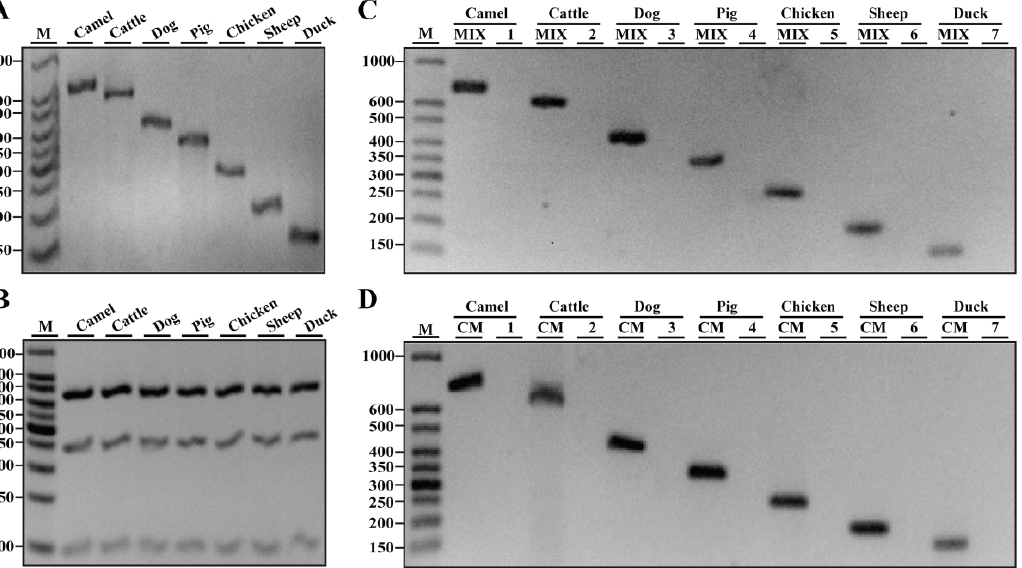
Figure 1. Verification of primer specificity with conventional simplex PCR. ( A ) Simplex PCR detec- tion using species-specific primers for camel, cattle, dog, pig, chicken, sheep and duck origin and respective genomic DNA as the template. ( B ) PCR amplification with premixed universal primers of eukaryotic 12S rRNA, 16S rRNA and 18S rRNA genes for each meat species, respectively. ( C ) PCR amplification using individual template DNA from camel, cattle, dog, pig, chicken, sheep and duck species. MIX, a mixture of seven primer pairs of camel, cattle, dog, pig, chicken and sheep species; 1–7, a mixture of six primer pairs of six nontarget species. ( D ) PCR amplification with a pair of target primers. CM, a complete DNA mixture of seven species including camel, cattle, dog, pig, chicken, sheep and duck; 1–7, DNA mixture of six nontarget species. Lane M is ladder DNA. To further examine the specificity of the target primers in this multiplex assay, the genomic DNA of a single species was individually employed for multiplex PCR amplifi- cation. They produced the expected targets in the presence of all primer mixtures of seven but not six nontarget primer pairs (Figure 1C). Meanwhile, target primers could specifi- cally amplify target bands in the presence of the DNA mixture isolated from seven but not six nontarget species (Figure 1D). Collectively, it can be postulated that a target primer pair can specifically amplify target species. To further confirm the accuracy of the PCR amplification, target amplicons in Figure 1D were individually cloned and sequenced. DNA sequencing demonstrated that PCR products amplified by target primers showed an accuracy of 100% based on a BLAST search against the NCBI nucleotide database. In addition, target primers were confirmed without cross-reactivity against sixteen nontarget species through PCR assays (data not shown). Therefore, target primers are highly specific for the inspection of animal species. 3.2. Sensitivity of Multiplex PCR Assay Differing from simplex PCR assays, multiplex PCRs are complicated with the increas- ing multiplicity of PCR reaction caused by increased primer pairs. Based on simplex PCR system, multiplex PCR systems starting from duplex, triplex, tetraplex, pentaplex and hexaplex PCRs were gradually developed and a heptaplex PCR method was ultimately constructed by seven sets of target primers. To examine the limit of detection (LOD) and dynamic range of this method, multiplex PCR assays were performed using the serial DNA concentration of each species. As shown in Figure 2A, seven bands corresponding to seven species were clearly visible at concentrations ranging from 10 to 0.025 ng DNA, while 0.01 ng DNA of some species generated relatively weak bands. According to the bands, electropherograms were drawn using Image Lab TM Software, in which the intensi- ties of the peak patterns were associated with the brightness of the bands. With decreasing DNA concentrations, the intensities of peaks were obviously reduced showing a severe